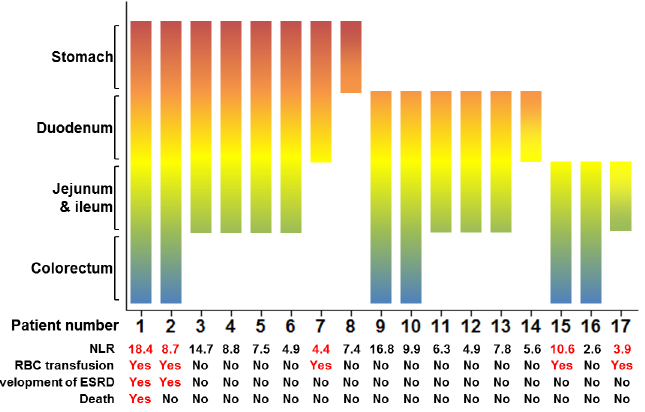
Fig 4. Clinical outcomes of patients with gastrointestinal bleeding. Bar represents the location of gastrointestinal bleeding in each patient. NLR, neutrophil-to-lymphocyte ratio; RBC, red blood cells; ESRD, end-stage renal